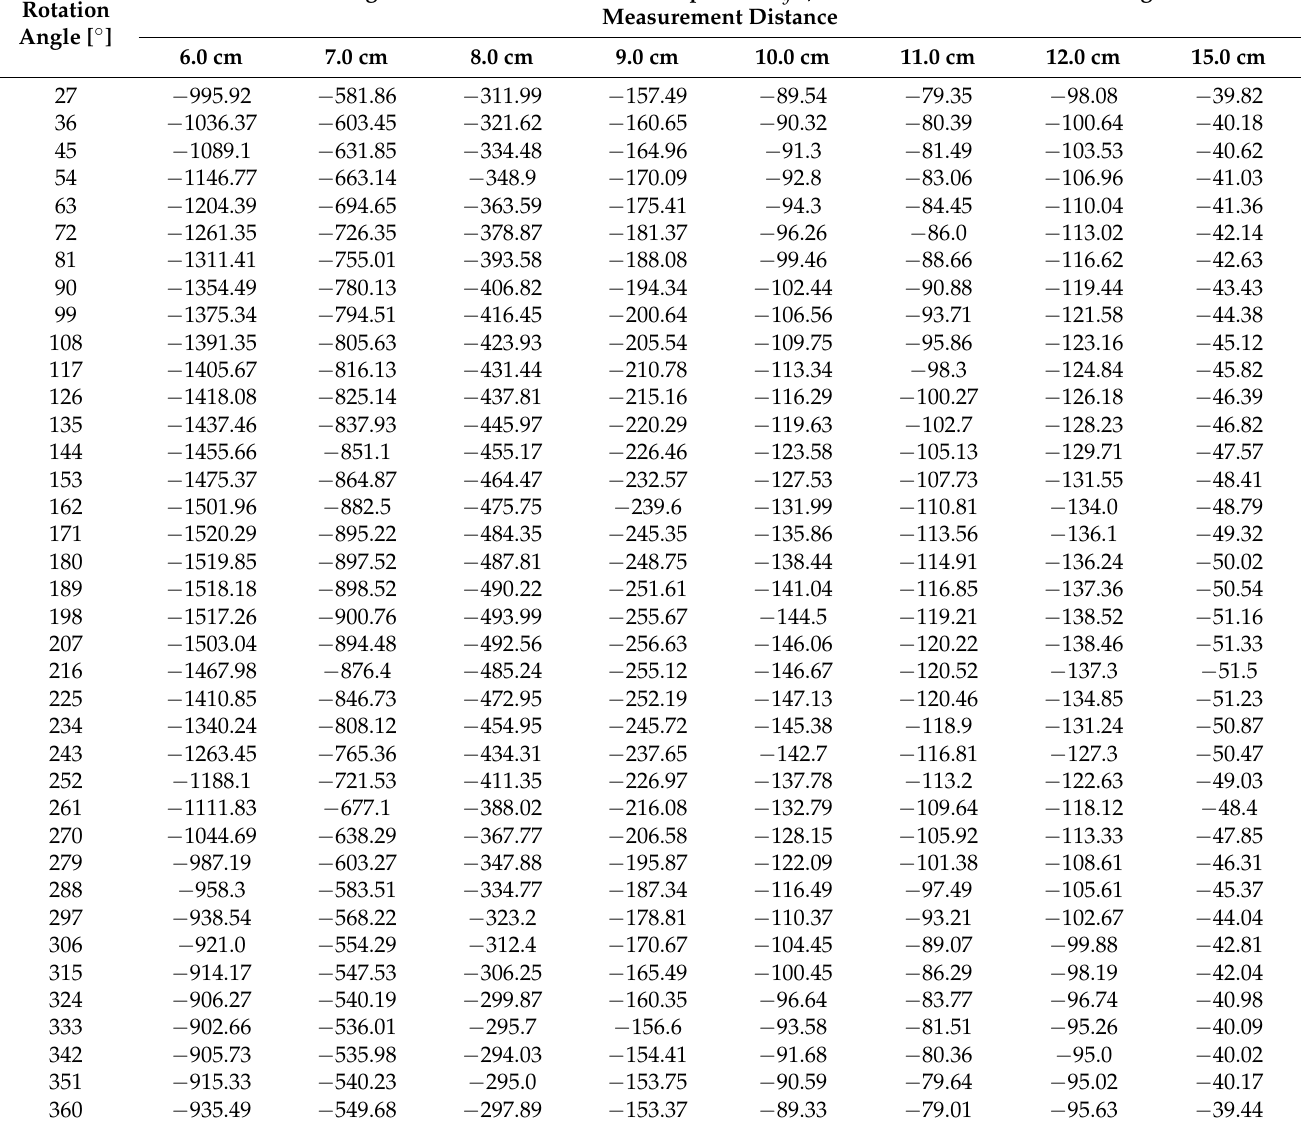
Table 5. Estimated values of the B z component of magnetic induction as a function of rotation angle and measurement